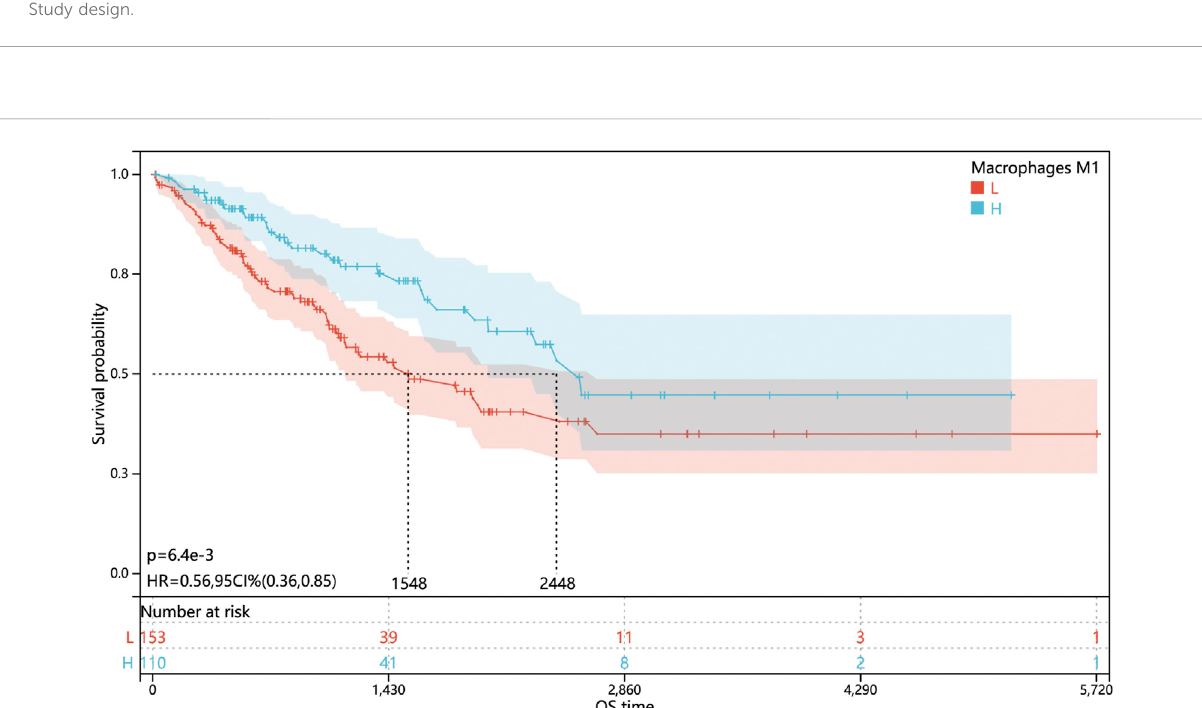
FIGURE 2 Level of M1-like macrophage in fi ltration associated with better prognosis in soft tissue sarcomas. Kaplan – Meier overall survival curves of STS patients in TCGA cohort strati fi ed by a low or high M1-like macrophage in fi ltration level.